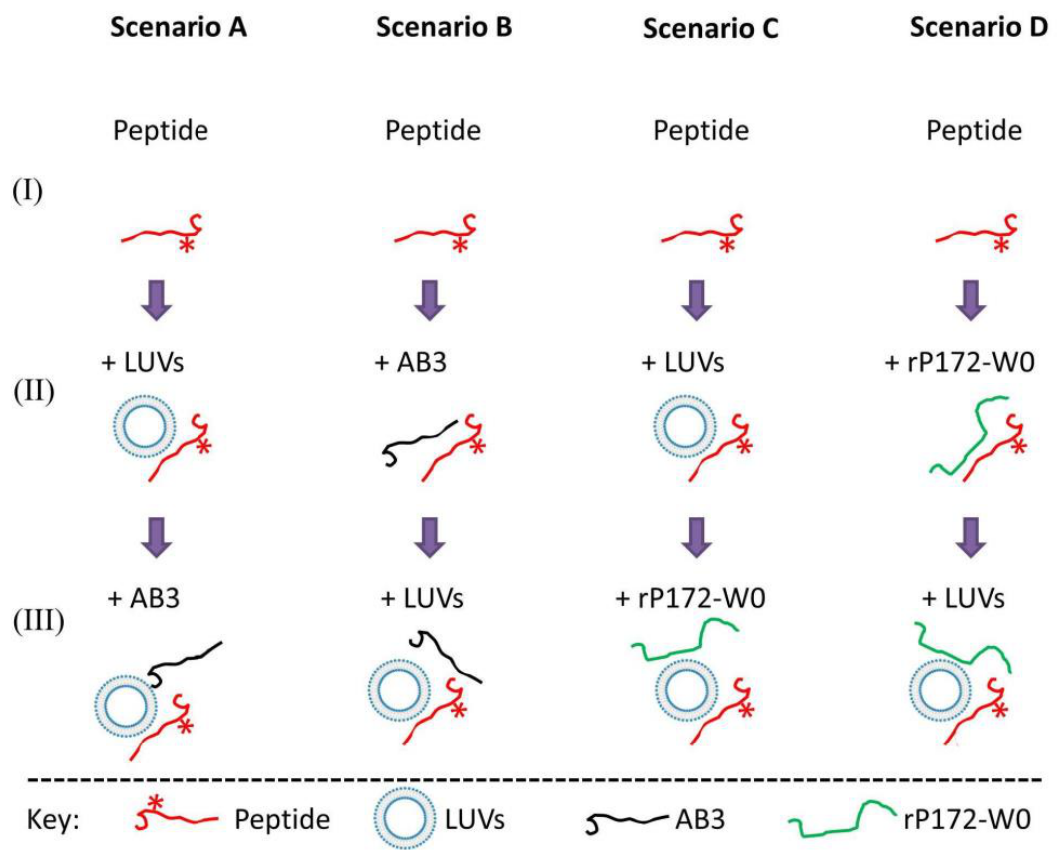
Figure 5. Schematic representation for three-component systems used in tryptophan fluorescence measurements in Figures 6 and 8 and EPR experiments in Figure 9. First, AB2, AB2N, xAB2N, or AB2N-W14Y was measured in the absence of another component (I). In Scenario A, LUVs were subsequently added, and fluorescence spectra were measured again (II). Then, AB3, which does not contain tryptophan residues, was added to the mixture, and a third measurement was made (III). In Scenario B, AB3 was added to the tryptophan-containing peptide first (II), followed by LUVs (III). Scenarios C and D are the counterparts to Scenarios A and B, respectively, with rP172-W0, or non-tryptophan-containing Amel, added in place of AB3.